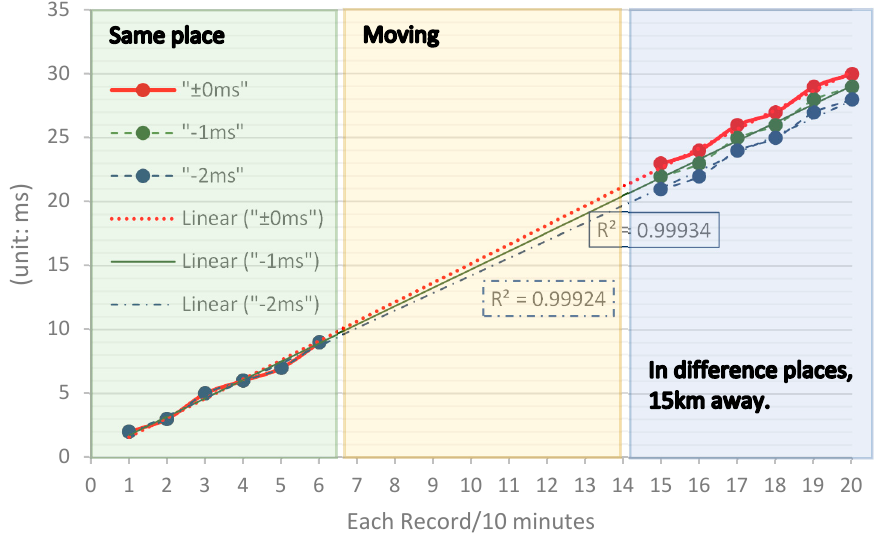
Figure 23. Comparison of synchronized experiments with − 1 ms and − 2 ms corrections.